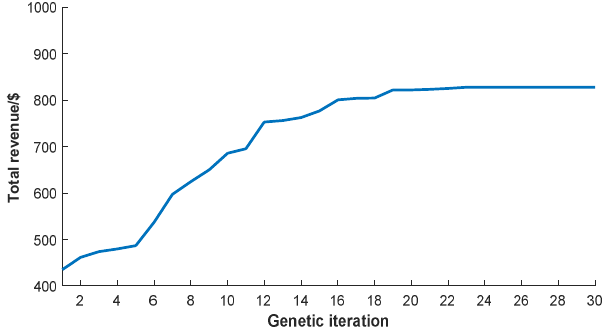
Figure 9 . Optimization convergence trace of genetic algorithm (GA). Figure 9. Optimization convergence trace of genetic algorithm (GA).